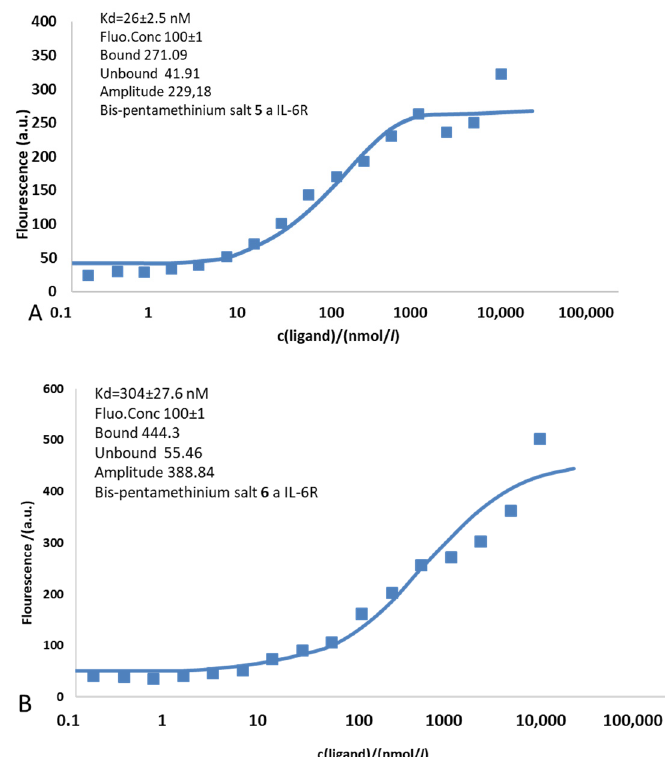
Figure 4. Binding of Bis PMS to the IL ‐ 6 receptor (IL ‐ 6R) containing α and β subunits evaluated by a microscale thermophoresis assay. The binding isotherm of Bis ‐ PMSs 5 ( A ) and 6 ( B ) resulting from plotting the difference in normalized fluorescence against the concentration of the non ‐ fluorescent binding partner (ligand–IL ‐ 6R).